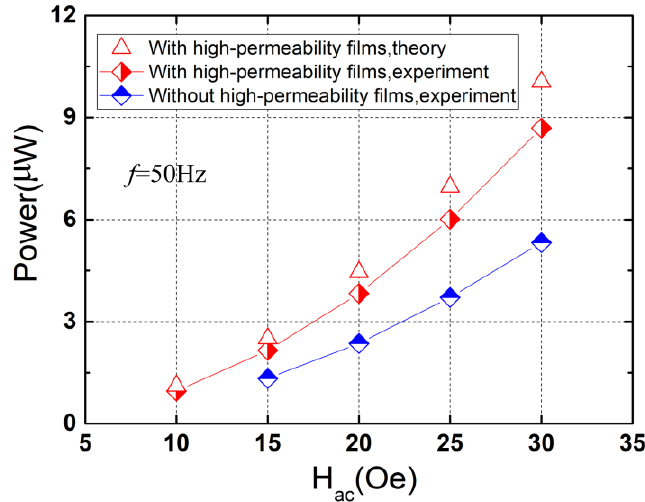
Figure 8. Maximum output power versus the applied alternating magnetic field.